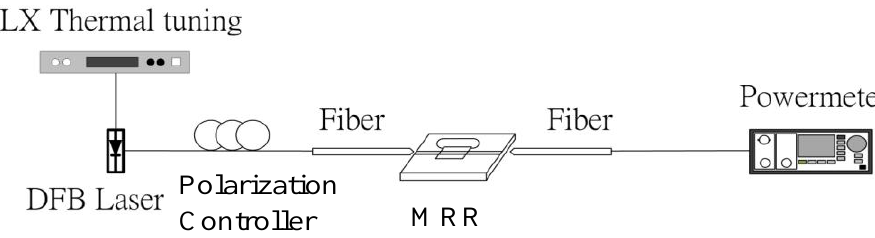
Figure 10. The test setup for MMR Q factor